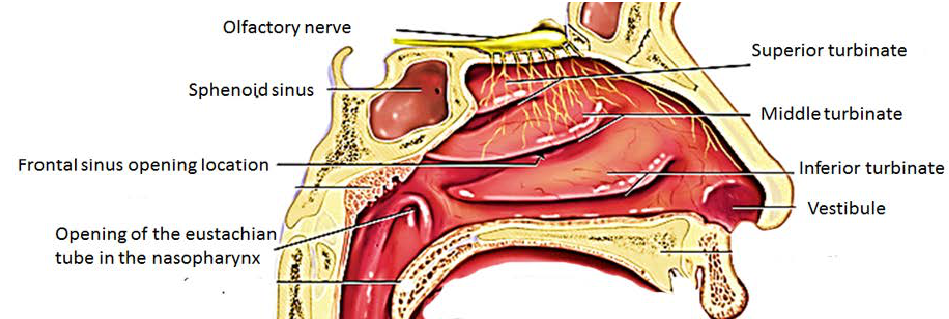
Figure 1. Anatomy of the nose.